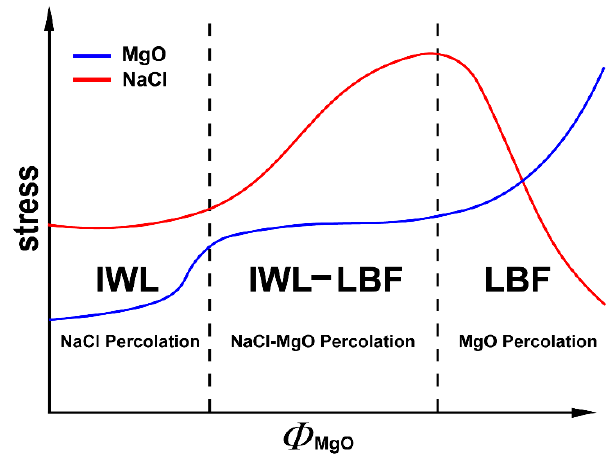
Figure 17. Stress evolution of individual phases with the MgO phase proportion. Blue line is for MgO and the red line is for NaCl.